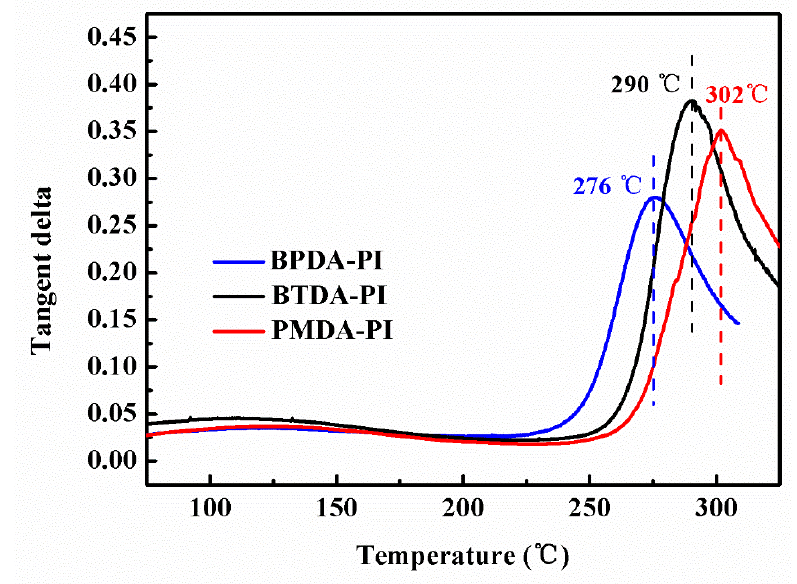
Figure 6. DMA curves of the PI films.